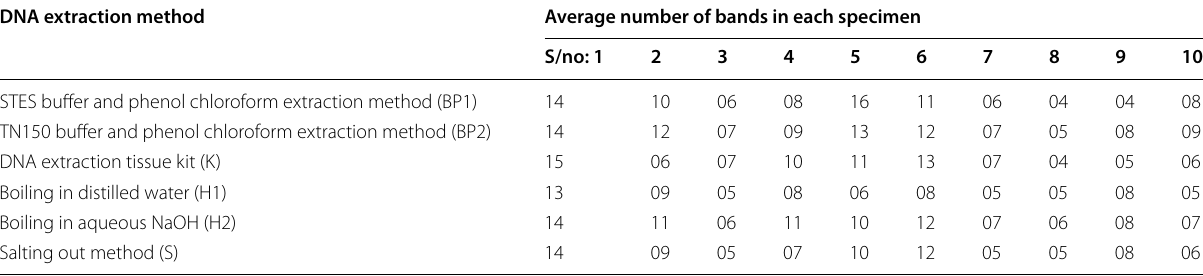
S/No specimen number